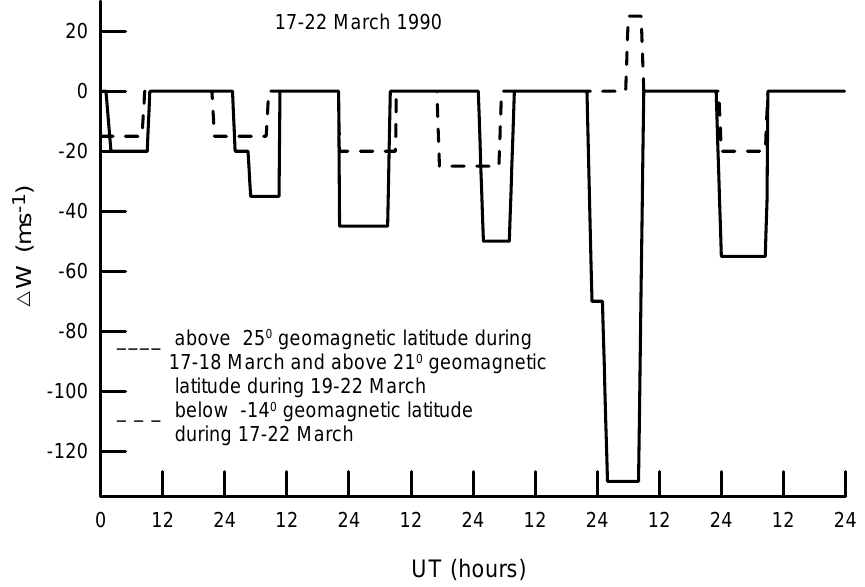
Fig. 7. Diurnal variations of the additional meridional neutral wind, 1 W, when the original value of the meridional HWW90 neutral wind, W, is changed to W+ 1 W. The magnitude of 1 W is used in the Northern Hemisphere (solid line) above the geomagnetic latitude of 25 ◦ during 17–20 March and above the geomagnetic latitude of 21 ◦ during 19–22 March and in the Southern Hemisphere (dashed line) below the geomagnetic latitude of –14 ◦ during 17–22 March 1990, while 1 W=0 at the geomagnetic equator. A square interpolation of 1 W is employed between –14 ◦ and 0 ◦ , between 21 ◦ and 0 ◦ , and between 25 ◦ and 0 ◦ of the geomagnetic latitude,